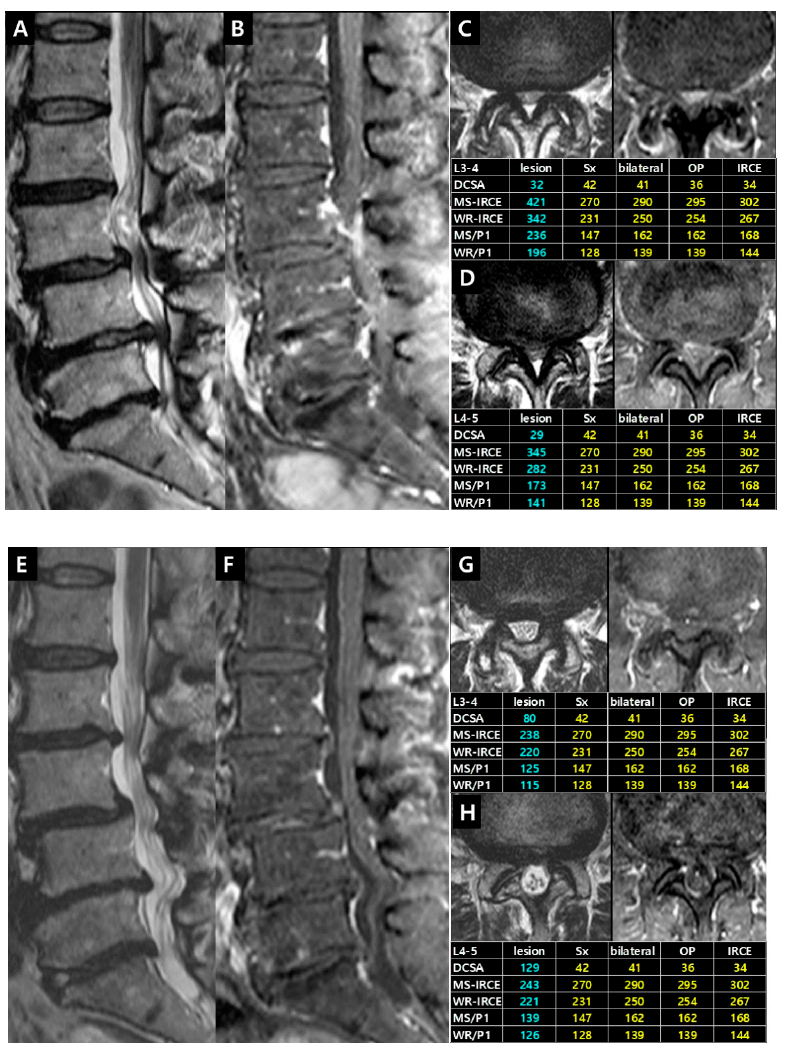
Figure 10. Illustrative Case 2. ( A , B ) Sagittal MR images revealed the definite central stenosis on